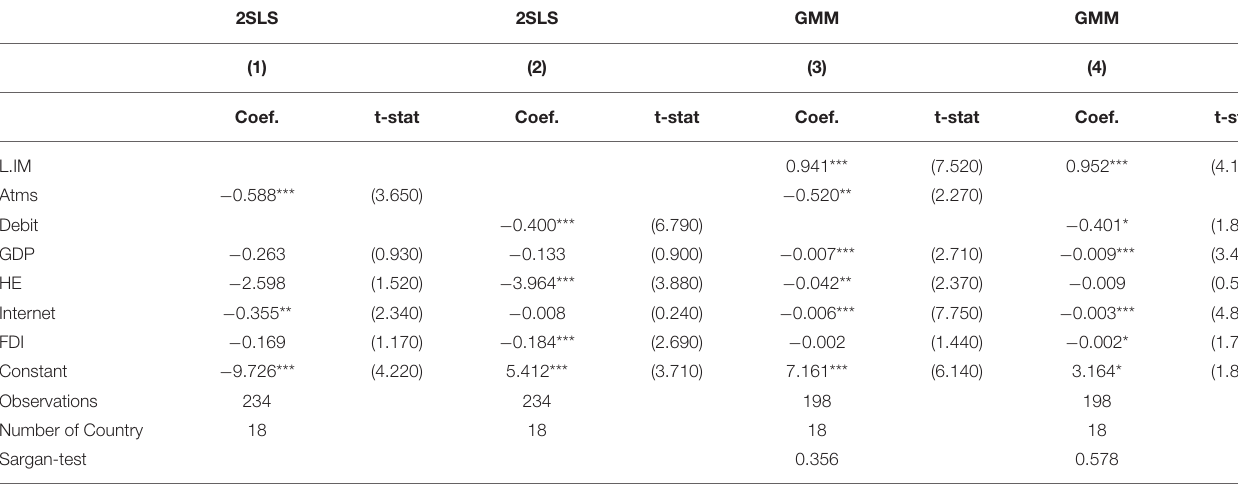
TABLE 2 | FinTech and infant mortality (2SLS and GMM).